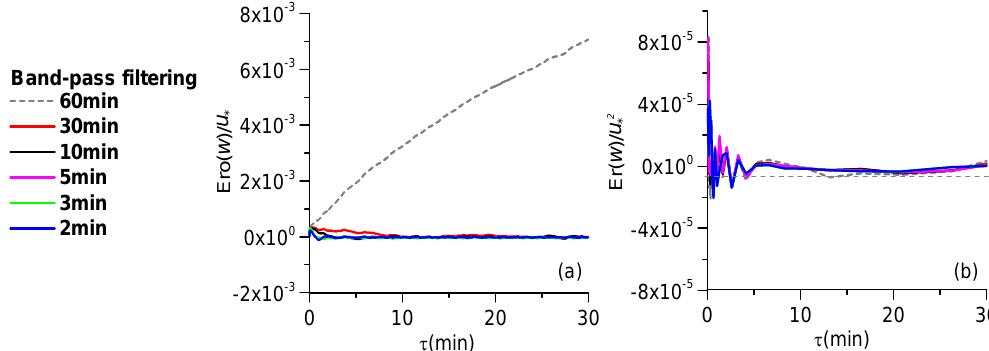
Figure 6. Variation of mean ergodic function (a) and autocorrelation ergodic function (b) of the vertical velocity with relaxation time for the different scale eddies in the seven stations of